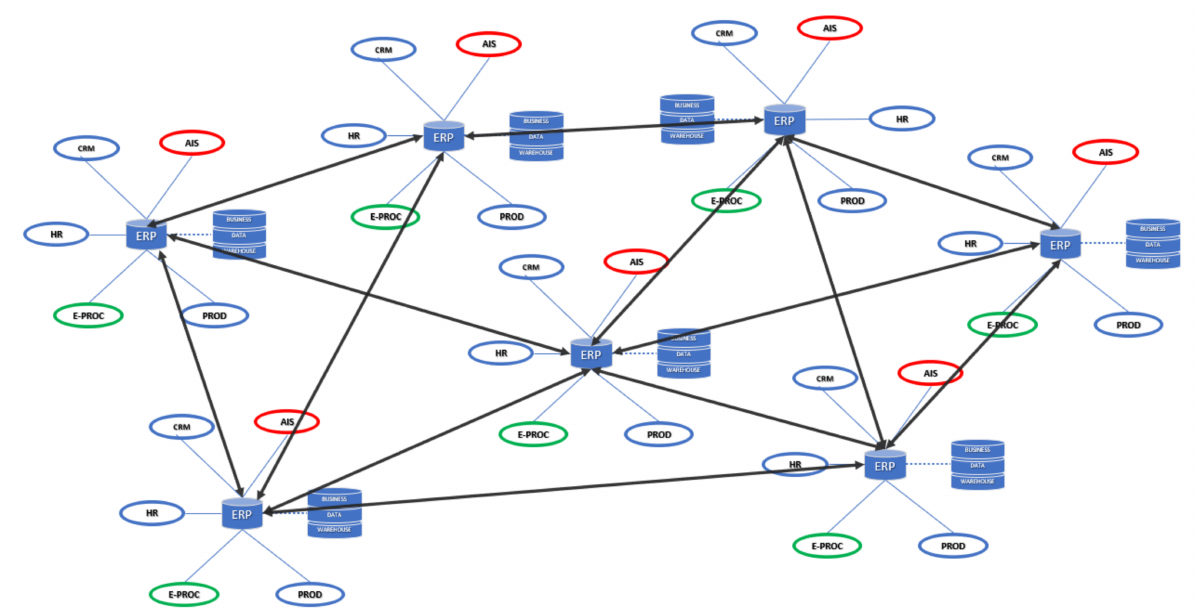
Figure 3. Decentralised Business Systems Network.